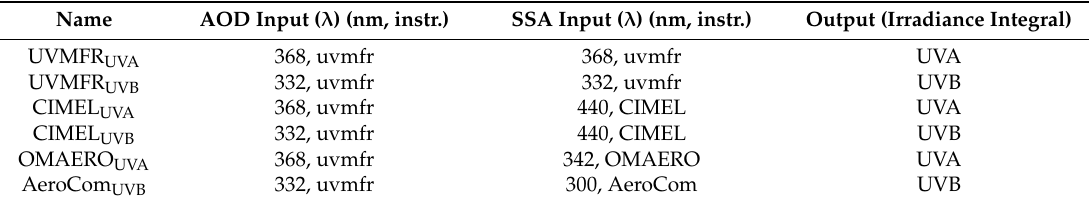
Table 1. UVA and UVB output datasets of RTM runs, characterized by SSA and AOD used in each case. Result names are characterized by the SSA dataset used.